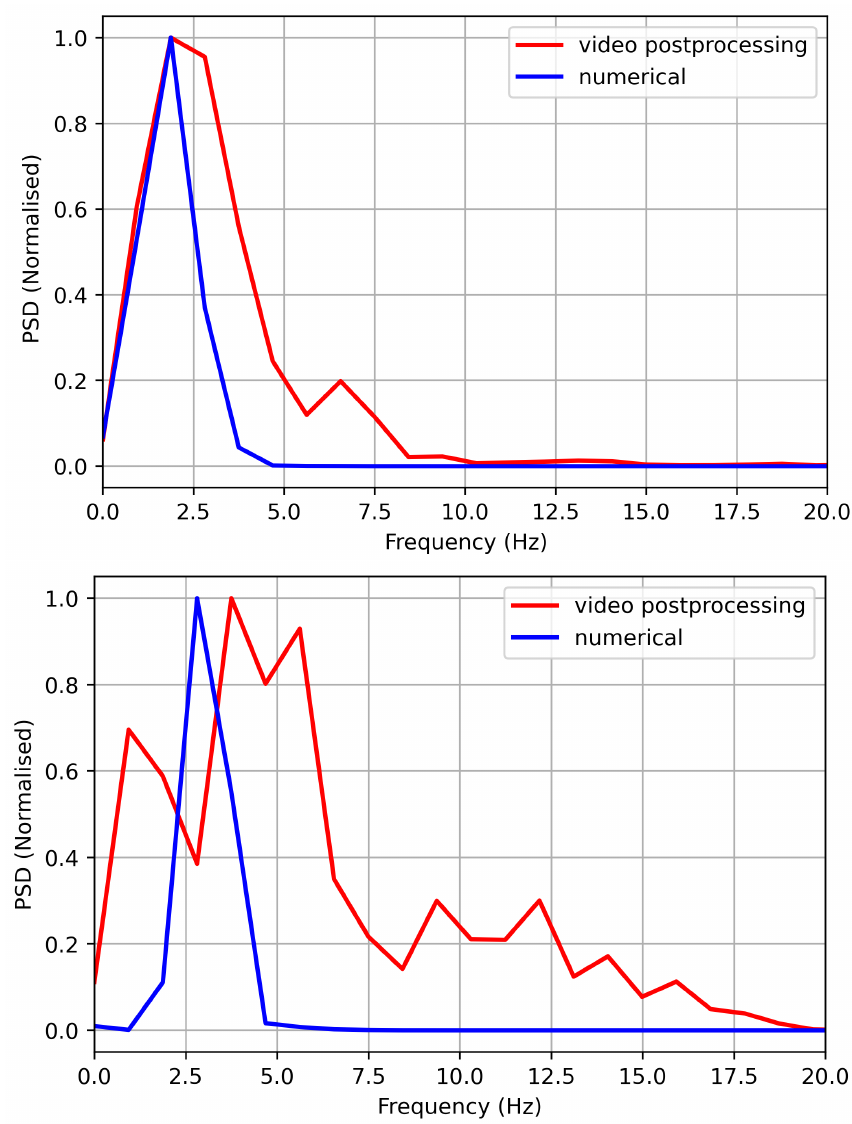
Figure 20. Normalized power spectral density (PSD) of the wind speed in the selected point for the 5 m/s and 10 m/s